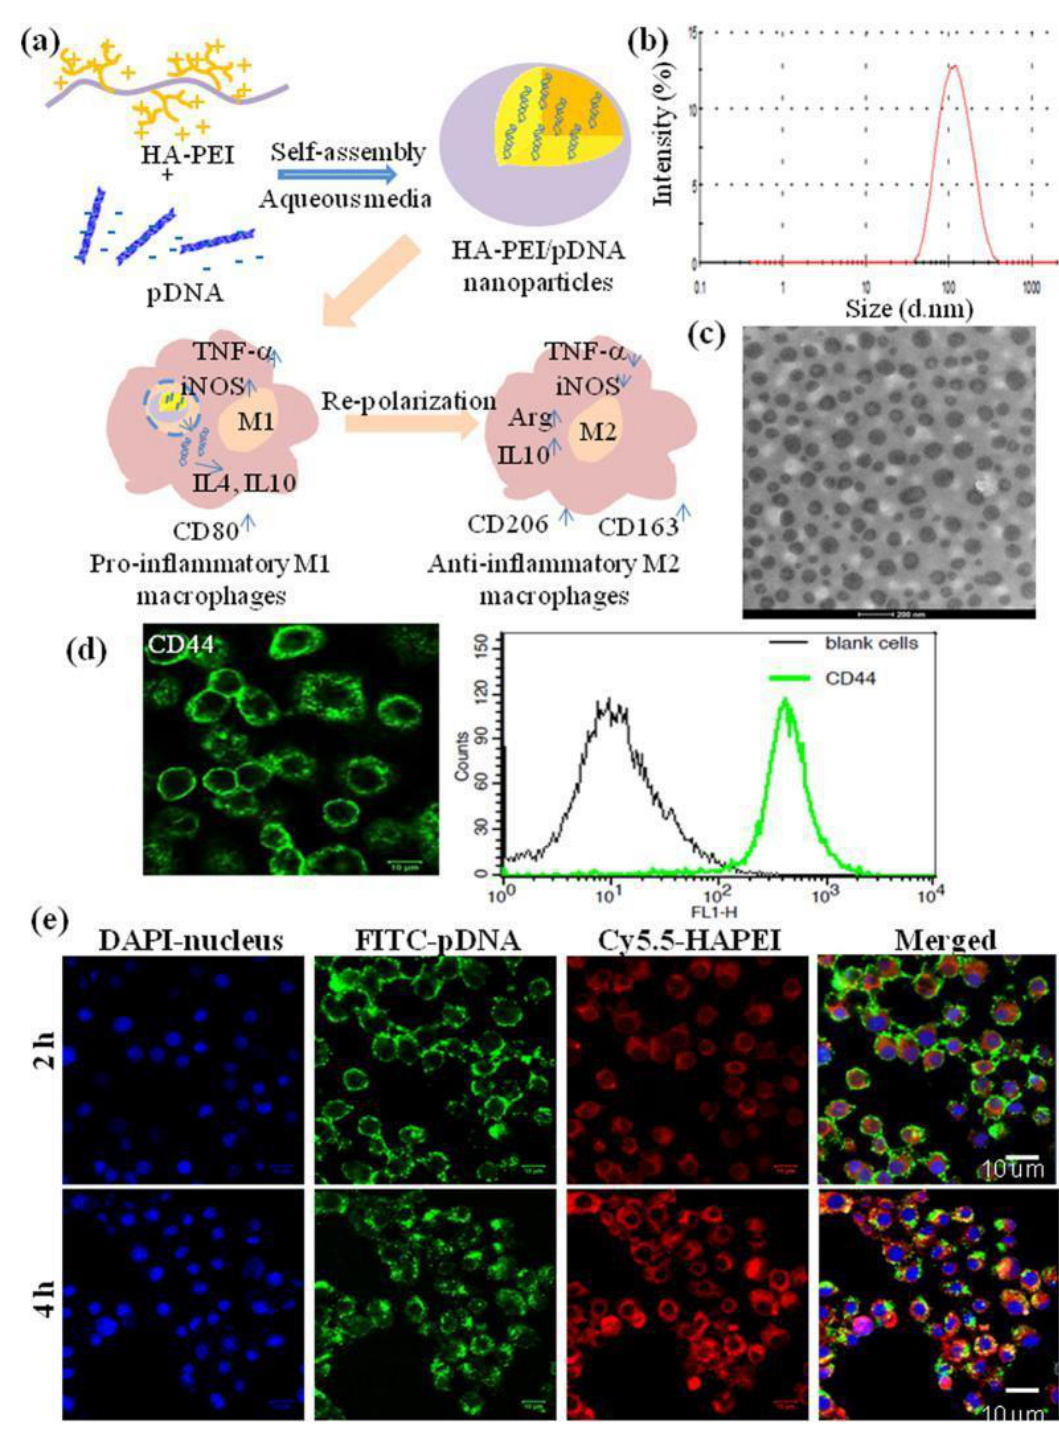
Figure 6. ( a ) Schematic illustration of pDNA encapsulation into HA-PEI nanoparticles for the re- polarization of pro-inflammatory M1 macrophages to anti-inflammatory M2 macrophages. ( b ) Size distribution of HA-PEI/pDNA (9:1) in PBS by DLS. ( c ) TEM image of HA-PEI/pDNA in PBS (9:1). ( d ) Confocal microscopy and FACS analysis of CD44 expression in J774A.1 macrophages. ( e ) Uptake of HA-PEI/pDNA nanoparticles in J774A.1 macrophages. Reprinted with permission from [91].